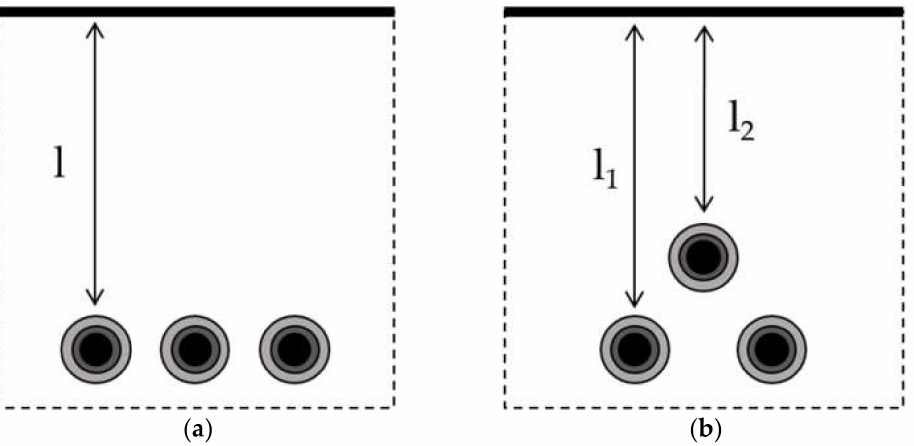
Figure 6. Cable arrangement in a three-phase cable line: ( a ) flat, where l = 0.7 m is the cable recess, ( b ) triangular, where l 1 = 0.7 m and l 2 = 0.65 m are the cable